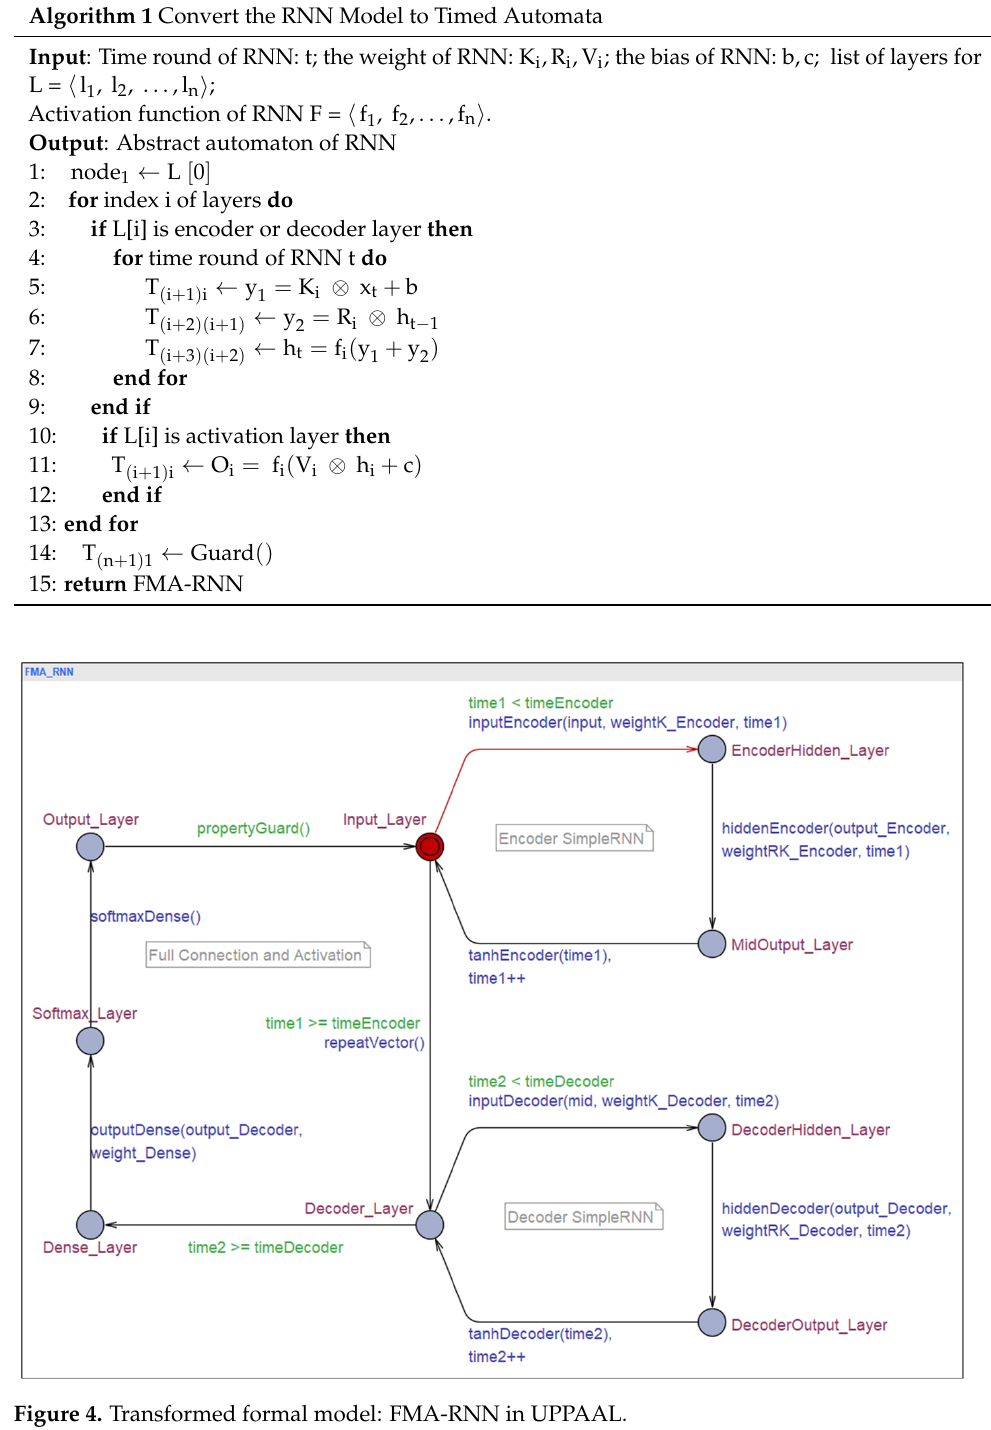
Figure 4. Transformed formal model: FMA ‐ RNN in UPPAAL.